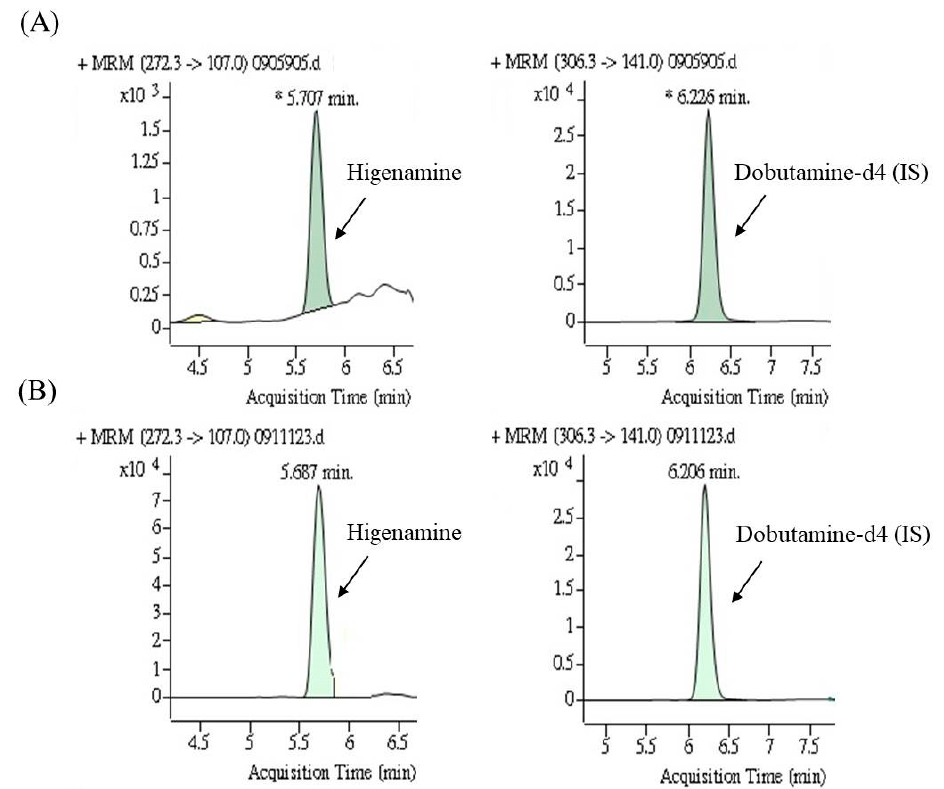
Figure 3. The multiple reaction monitoring (MRM) chromatograms of higenamine and internal standard: ( A ) Blank urine sample spiked with 0.5 ng/mL of higenamine and ( B ) the urine sample after consuming herbal extract product (HEP-3) by a participant.